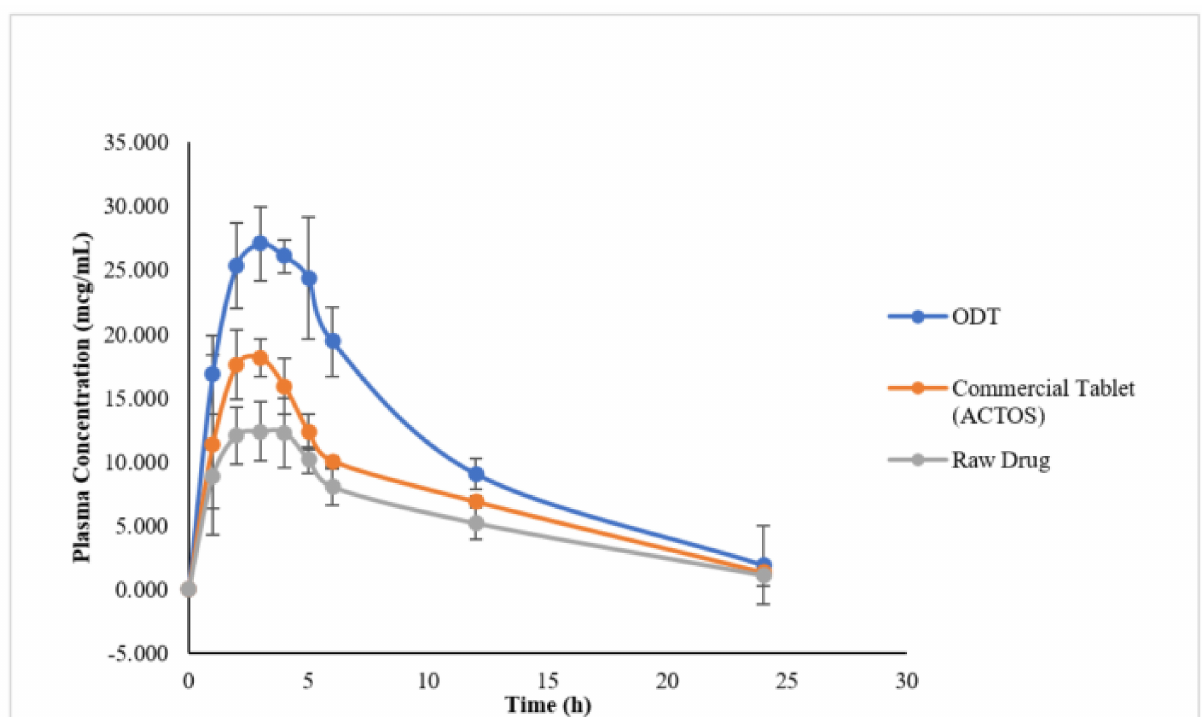
Figure 10. Plasma concentration vs. time profile of ODT tablets, commercial table and raw PGZ after a single dose oral administration to Wistar rats (mean ± SD, n = 6). Abbreviations: ODT, orally disintegrating tablet; PGZ, Pioglitazone